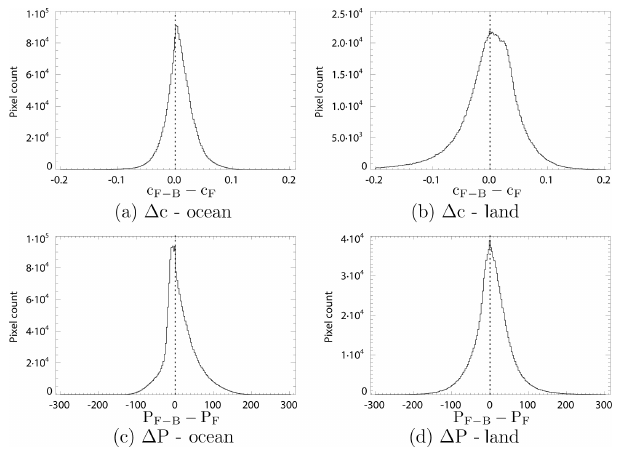
Figure 8. Histograms of the differences in effective cloud frac- tion (a, b) and cloud pressure (c, d) between FRESCO-B and FRESCO for July 2014 over ocean (a, c) and over land (b, d) .